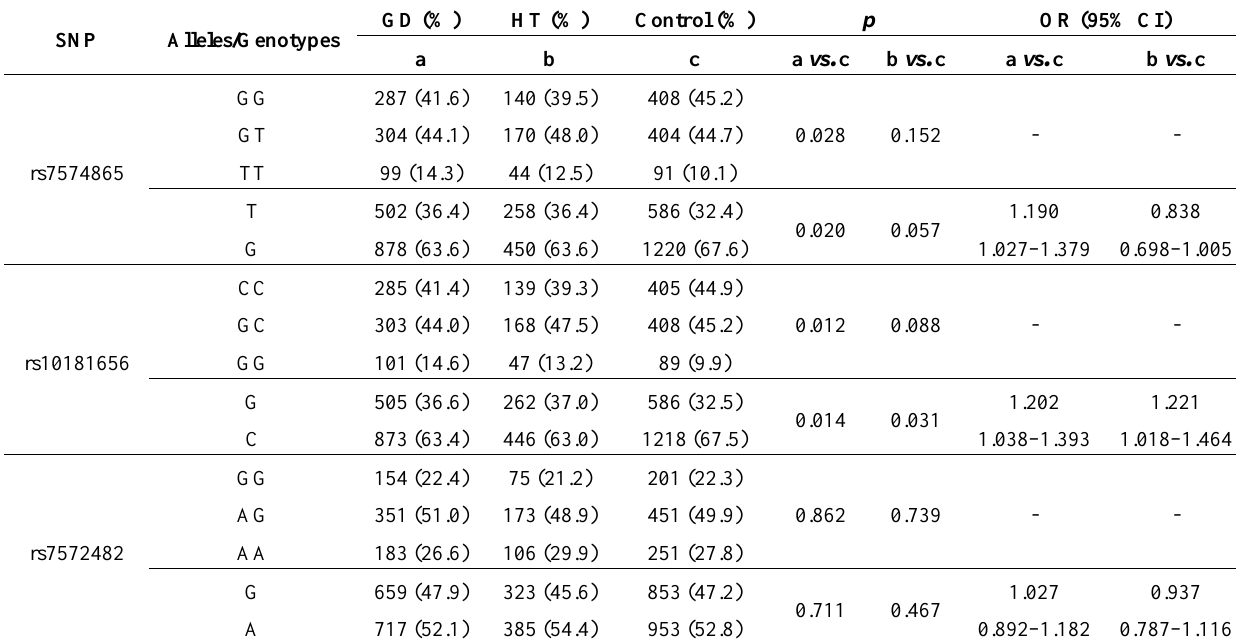
Table 3. Analysis of genotype and allele distribution of three STAT4 SNPs in GD, HT patients and